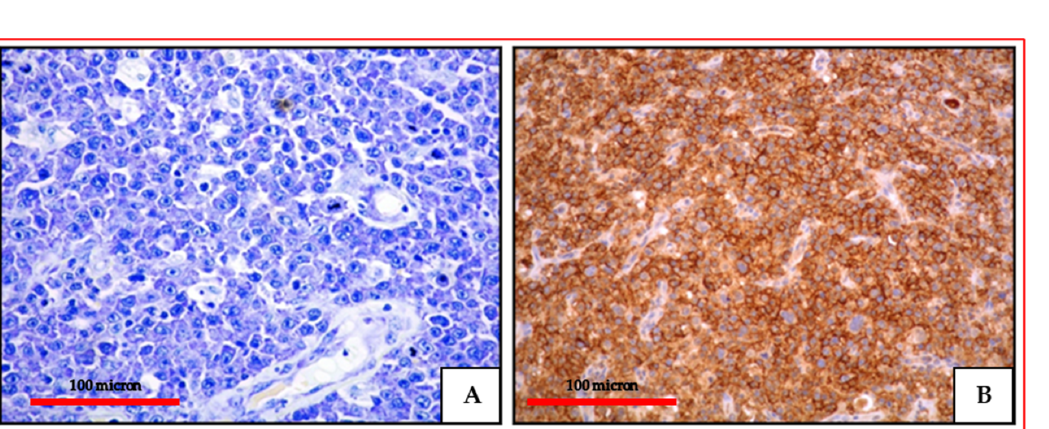
Figure 1. ( A ) PBL of the colon: high power view showing a diffuse proliferation of large-sized cells with evident nucleoli (Giemsa staining, magnification 400×; original image from Prof Ascani); ( B ) PBL of the colon: diffuse EMA expression of the neoplastic cells (immunostaining, Ventana immunostainer, magnification 400×; original image from Prof Ascani).